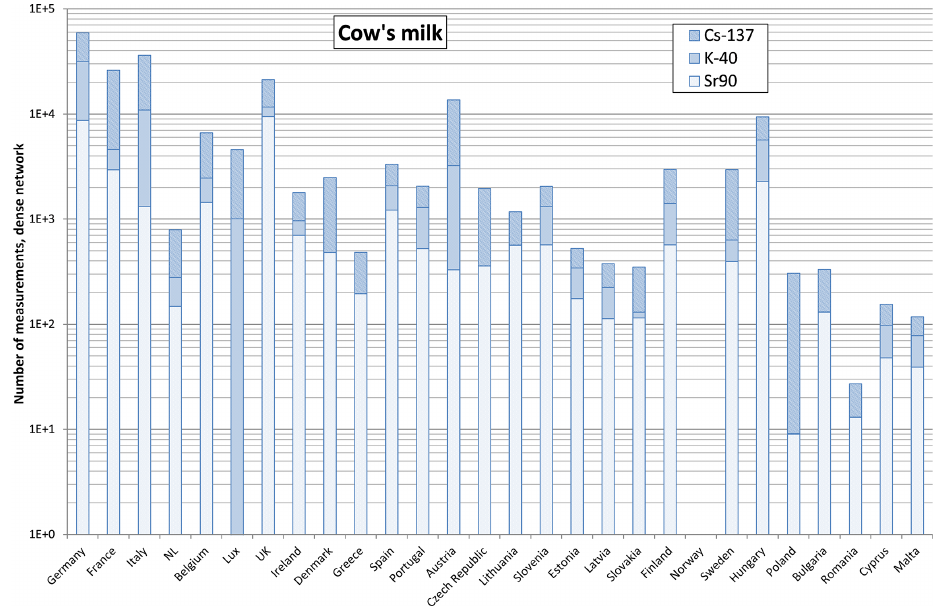
Figure 10. Number of measurements in REMdb (dense network) for sample type cow’s milk, 137 Cs, 40 K and 90 Sr, by country, as recom- mended in 2000/473/Euratom (2000).